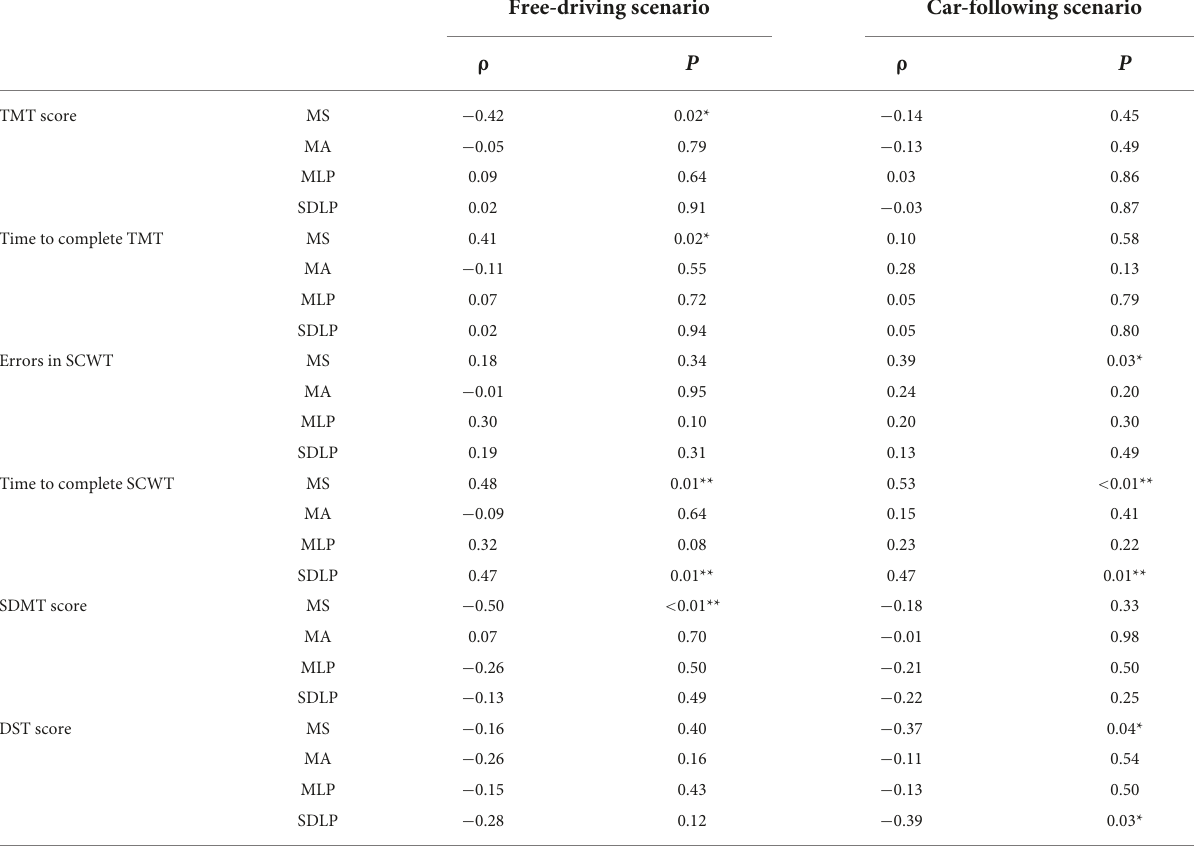
TABLE 4 Correlations between cognitive function and fatigued driving performance. Free-driving scenario Car-following